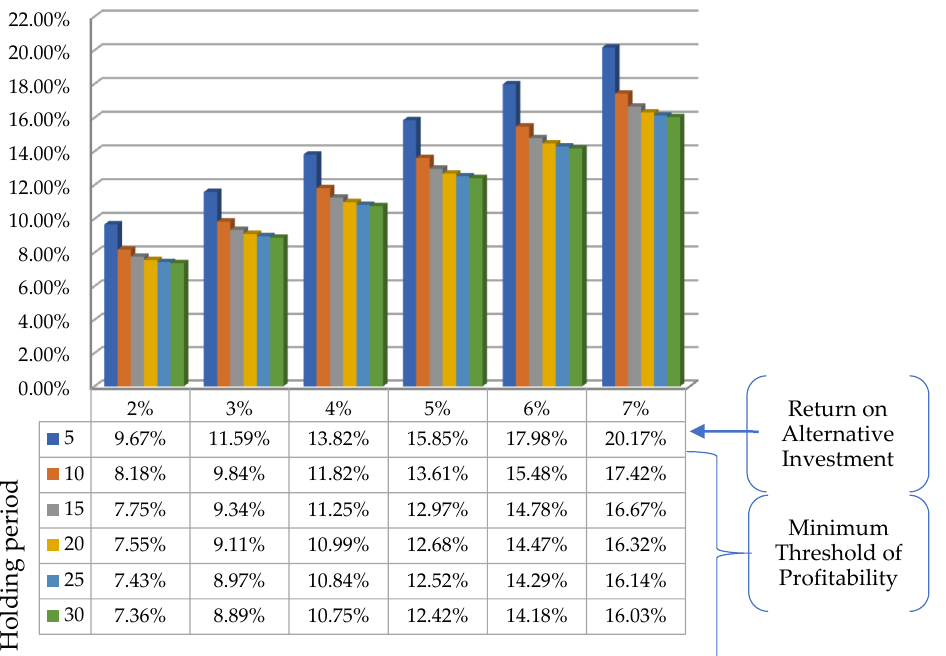
Figure 6. Distribution of the Pmt , depending on the holding period and return on alternative investment (case 2.1).